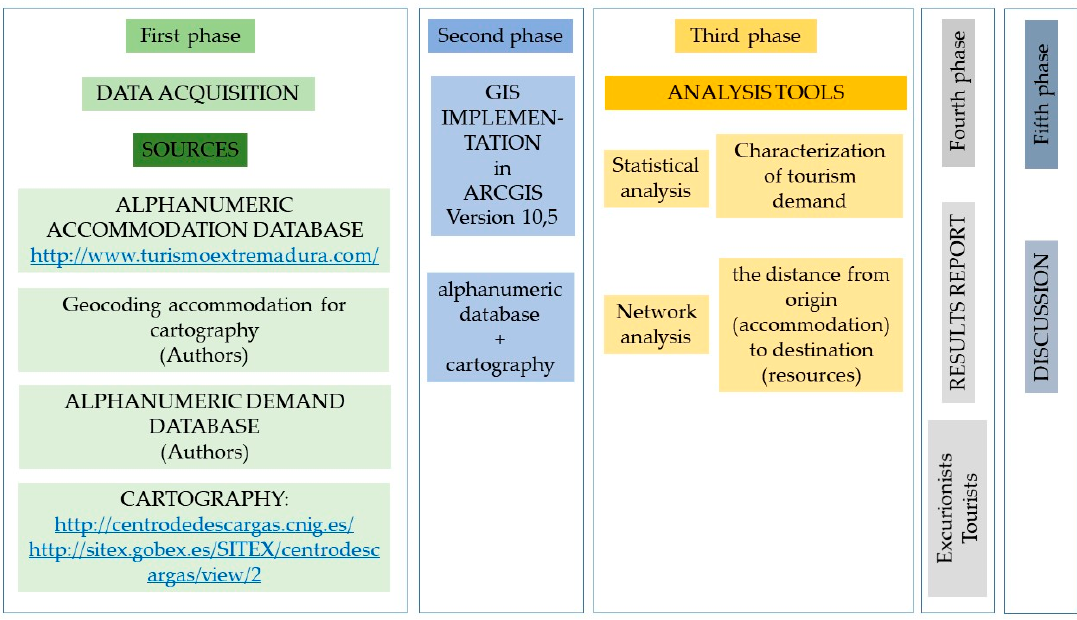
Figure 2. Methodology. Figure 2.